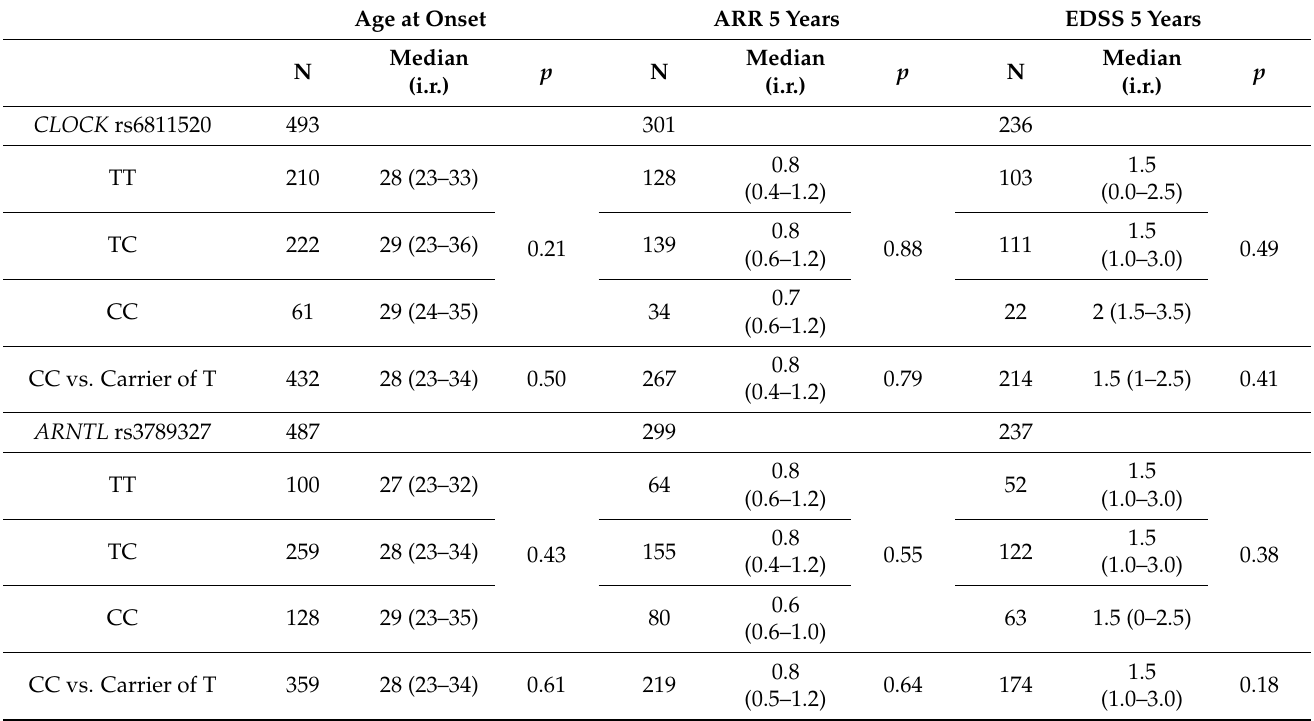
Table 3. Influence of CLOCK rs6811520 and ARNTL rs3789327 on age at onset and prognosis of MS. Age at onset is presented in years. Annual relapse rate (ARR) is calculated as the number of relapses in a given period (5 years after onset) divided by the time period. The Extended Disability Status Scale (EDSS) measures disability on a scale from 0 to 10, with 0 being no disability. Median and interquartile range (i.r.) are presented for all